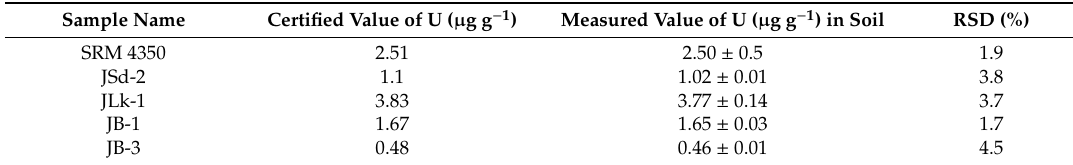
Table 1. U concentration of reference materials measured using inductively coupled plasma mass spectrometry